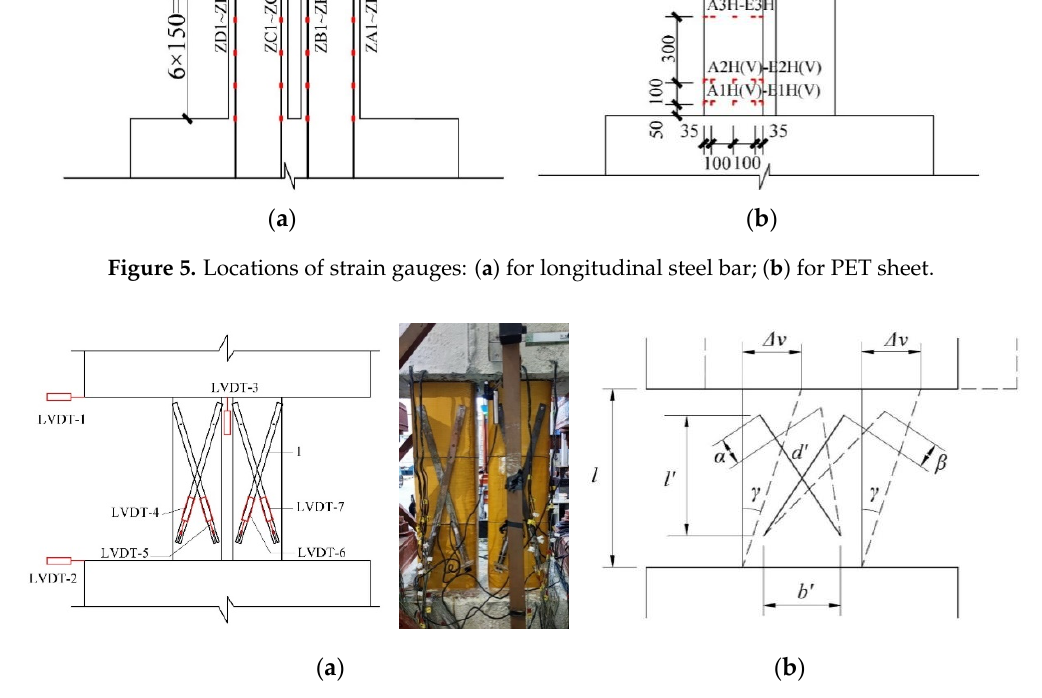
Figure 6. Diagrammatic sketch of shear deformation ( a ) locations of LVDTs; ( b ) calculation sketch of shear deformation.